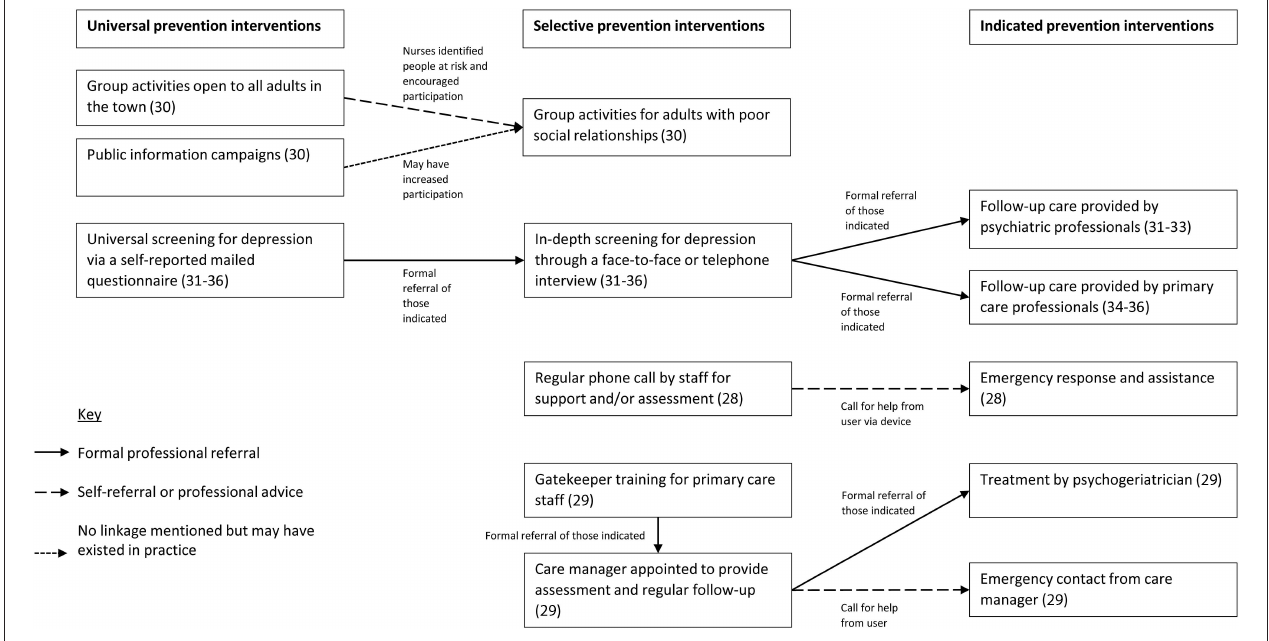
FIGURE 3 | Schematic diagram showing the nature of linkages between elements of the programs included in the